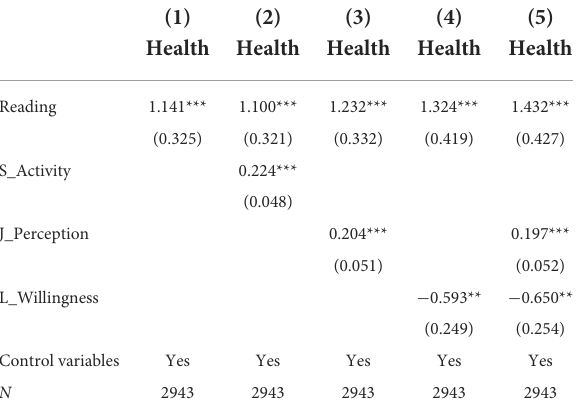
TABLE 8 Robustness test: Replacement of data source.